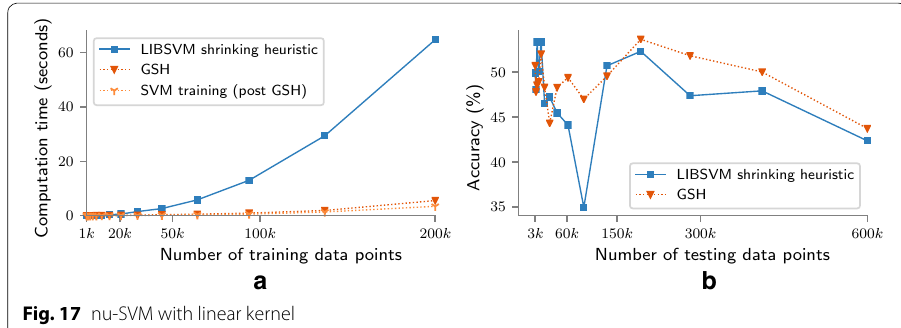
Fig. 17 nu-SVM with linear kernel